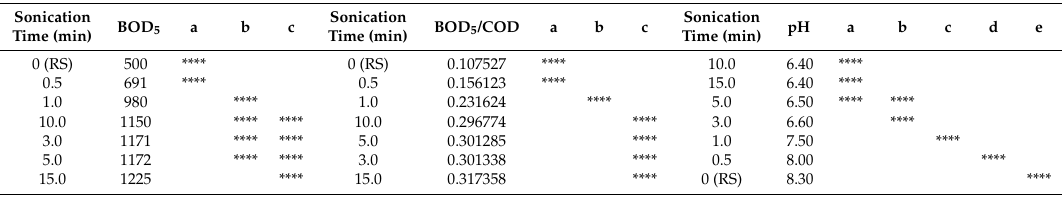
Table 3. Results of Tukey HSD test for BOD 5 ; BOD 5 /COD and pH—impact of sonication time on the indicated parameters (cells marked with stars and same letters in the table are not significantly different according to the carried out Tukey test ( p > 0.05).